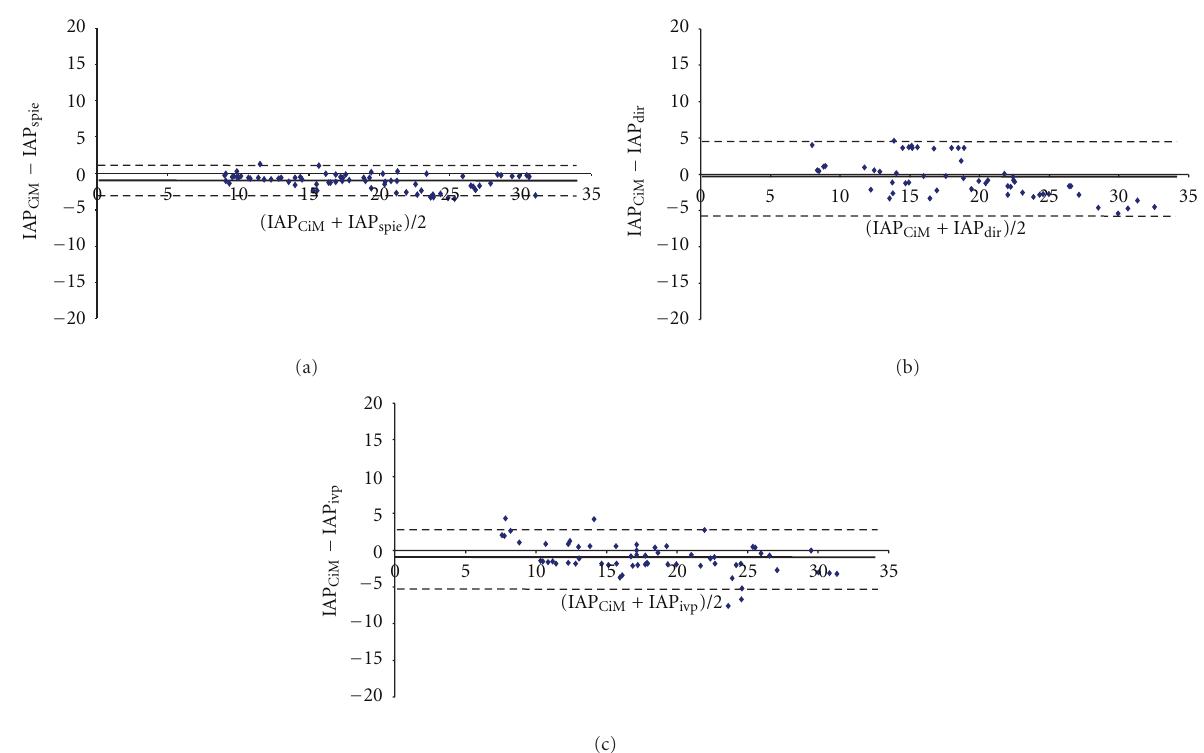
Figure 3: Bland Altman plots for comparing di ff erent methods measuring intra-abdominal pressure (IAP) in 25 ◦ head-of-bed position. Horizontal full line: bias; horizontal dashed line: upper and lower limits of agreement. (a) CiMON balloon-tipped catheter IAP measurement (IAP CiM ) versus Spiegelberg balloon-tipped catheter IAP measurement (IAP spie ). (b) IAP CiM versus direct intraperitoneal IAP measurement (IAP dir ). (c) IAP CiM versus intravesical pressure IAP measurement (IAP ivp